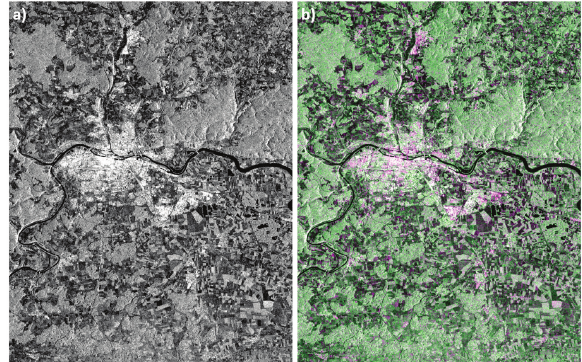
Figure 3: An example of the use of the Sentinel-1 dataset. a) VV polarisation image from 20. July 2015. b) RGB composite from VV, VH and VV from the same area and